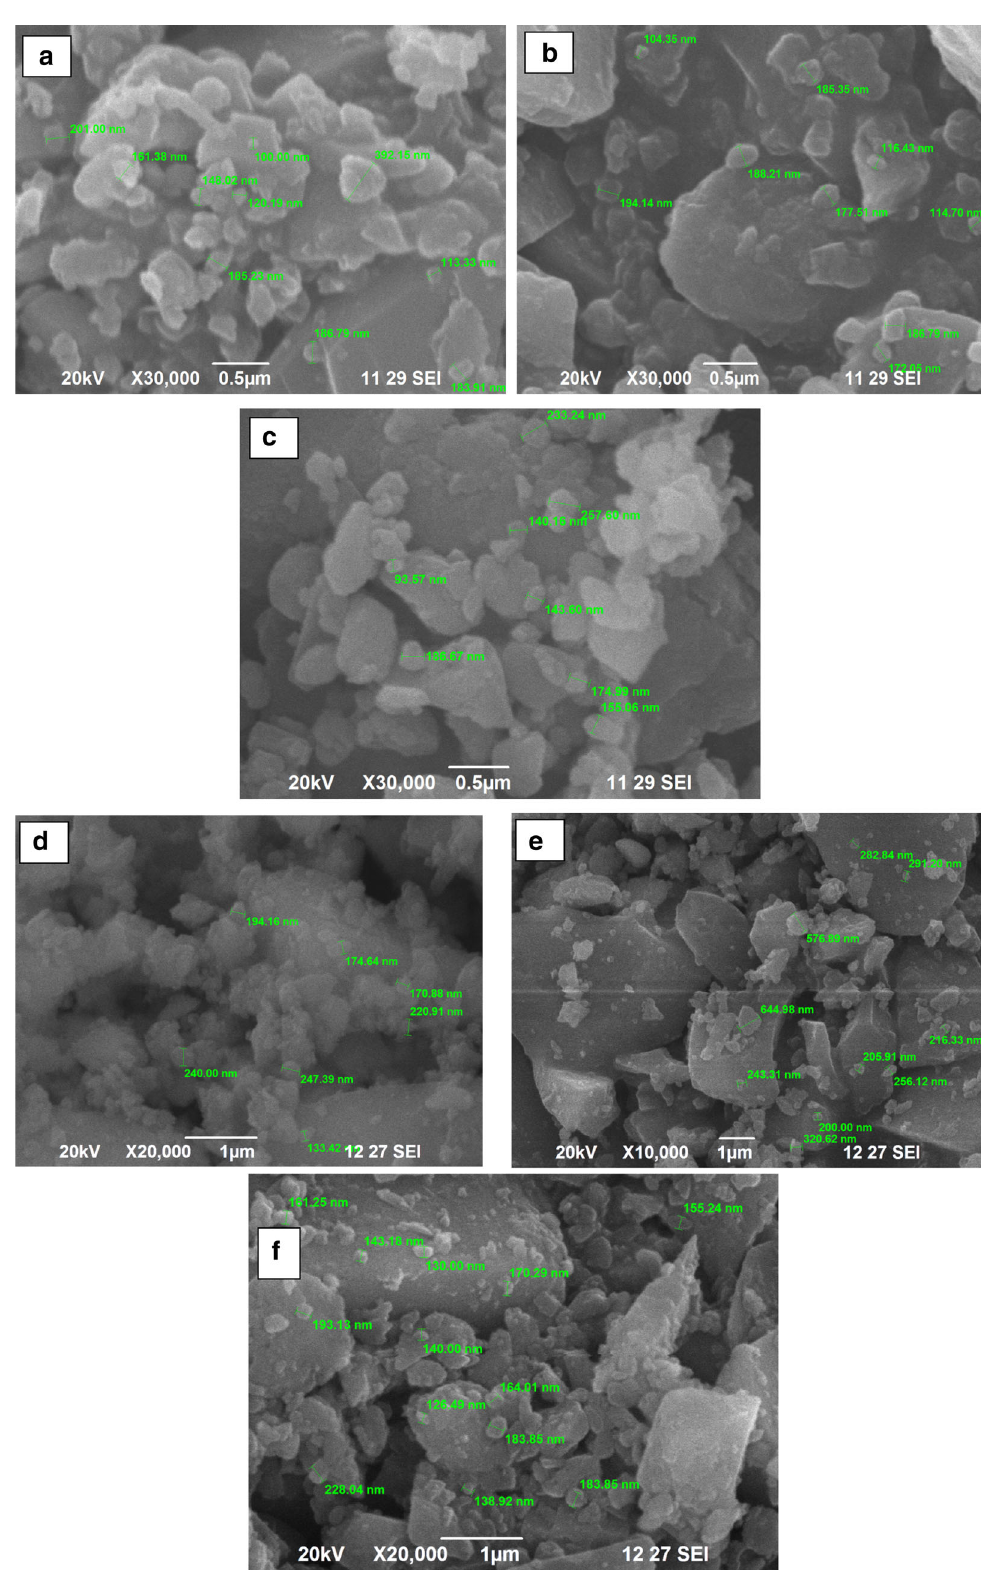
Fig. 8 SEM images of MOCP c-sand prepared with concentration 2, 4, 7 g of Moringa a – c before passing synthetic water through column and d – f after passing synthetic